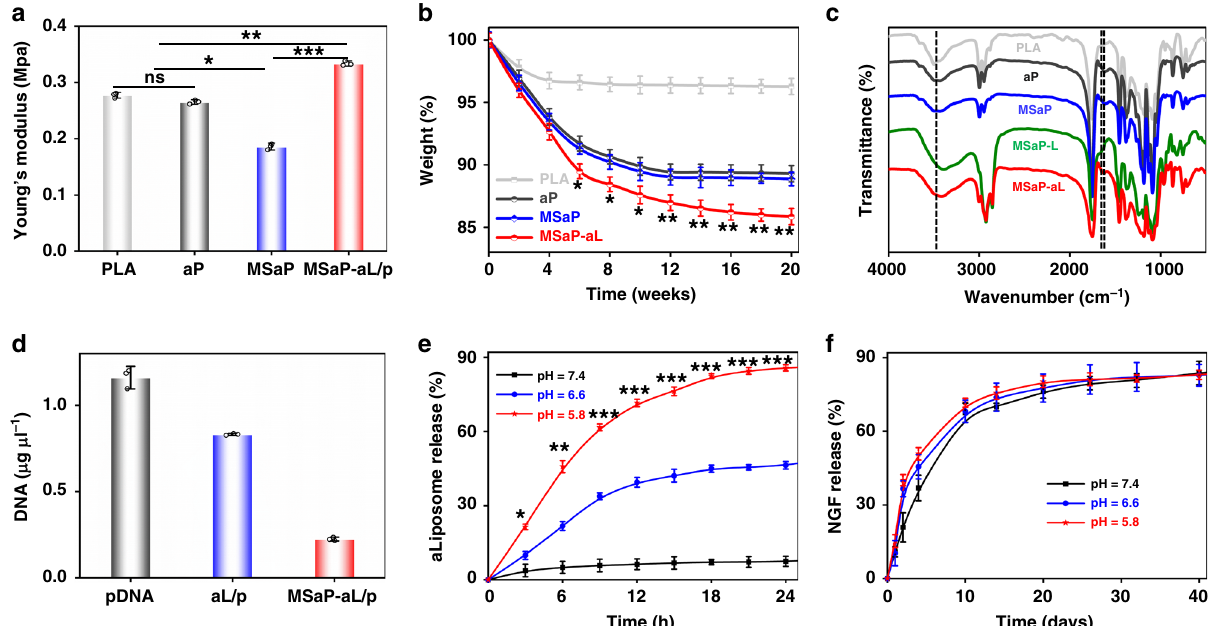
Fig. 5 The physiochemical performance of nano fi brous scaffolds. a Young ’ s modulus of different fi ber scaffolds ( n = 3, values were mean ± std. dev., * p < 0.05 when comparing MSaP and PLA (0.021) and aP (0.015) groups, respectively, ** p < 0.01 when comparing MSaP-aL/p and PLA (0.0062) and aP (0.0043) groups, respectively, and *** p < 0.001 when comparing MSaP-aL/p and MSaP (0.00054) via one-way analysis of variance (ANOVA) with Tukey ’ s post hoc test). b Degradation curve of different fi ber scaffolds ( n = 3, degradation values were mean ± std. dev., * p < 0.05, ** p < 0.01 when comparing MSaP-aL/p and three other samples at the same time point via two-way analysis of variance (ANOVA) with Tukey ’ s post hoc test). c FTIR spectra of different fi ber scaffolds. d Concentration of pDNA in the aLiposome solutions before and after grafting at the surface of scaffold ( n = 3, concentration of pDNA values were mean ± std. dev.). e Cumulative release curve of aLiposomes in different pH environments ( n = 3, aLiposome release values were mean ± std. dev., * p < 0.05, ** p < 0.01, *** p < 0.001 when comparing pH 5.8 and the other two pH at the same time via two-way analysis of variance (ANOVA) with Tukey ’ s post hoc test). f Cumulative release curve of NGF in microsol electrospinning in different pH environments ( n = 3,